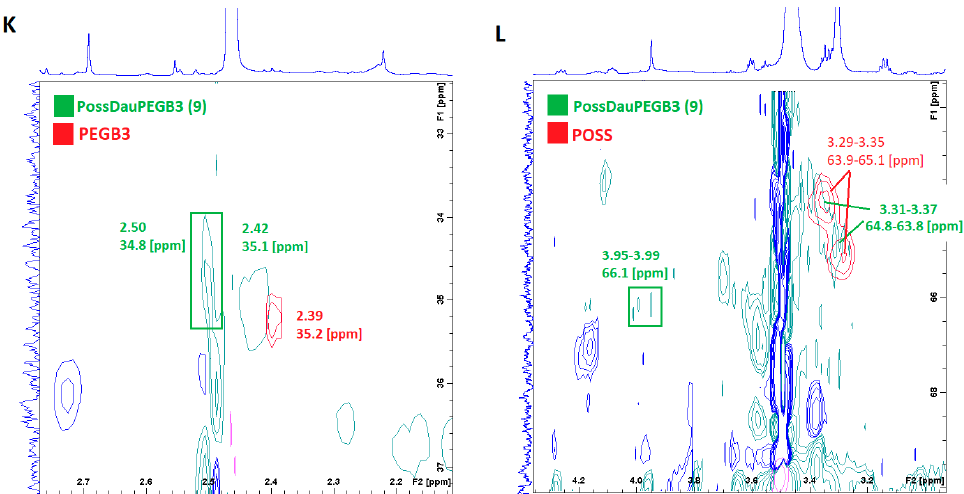
Figure 5. Superimposition of the 1 H- 13 C HSQC spectra of the substrates (PEG and POSS) on the 1 H- 13 C HSQC spectra of the products (conjugates 4 – 9 ). ( A , B ) PossDoxPEG1 ( 4 ); ( C , D ) PossDoxPEG2 ( 5 ); ( E , F ) PossDoxPEGB3 ( 6 ); ( G , H ) PossDauPEG1 ( 7 ); ( I , J ) PossDauPEG2 ( 8 ); ( K , L ) PossDauPEGB3 ( 9 ).